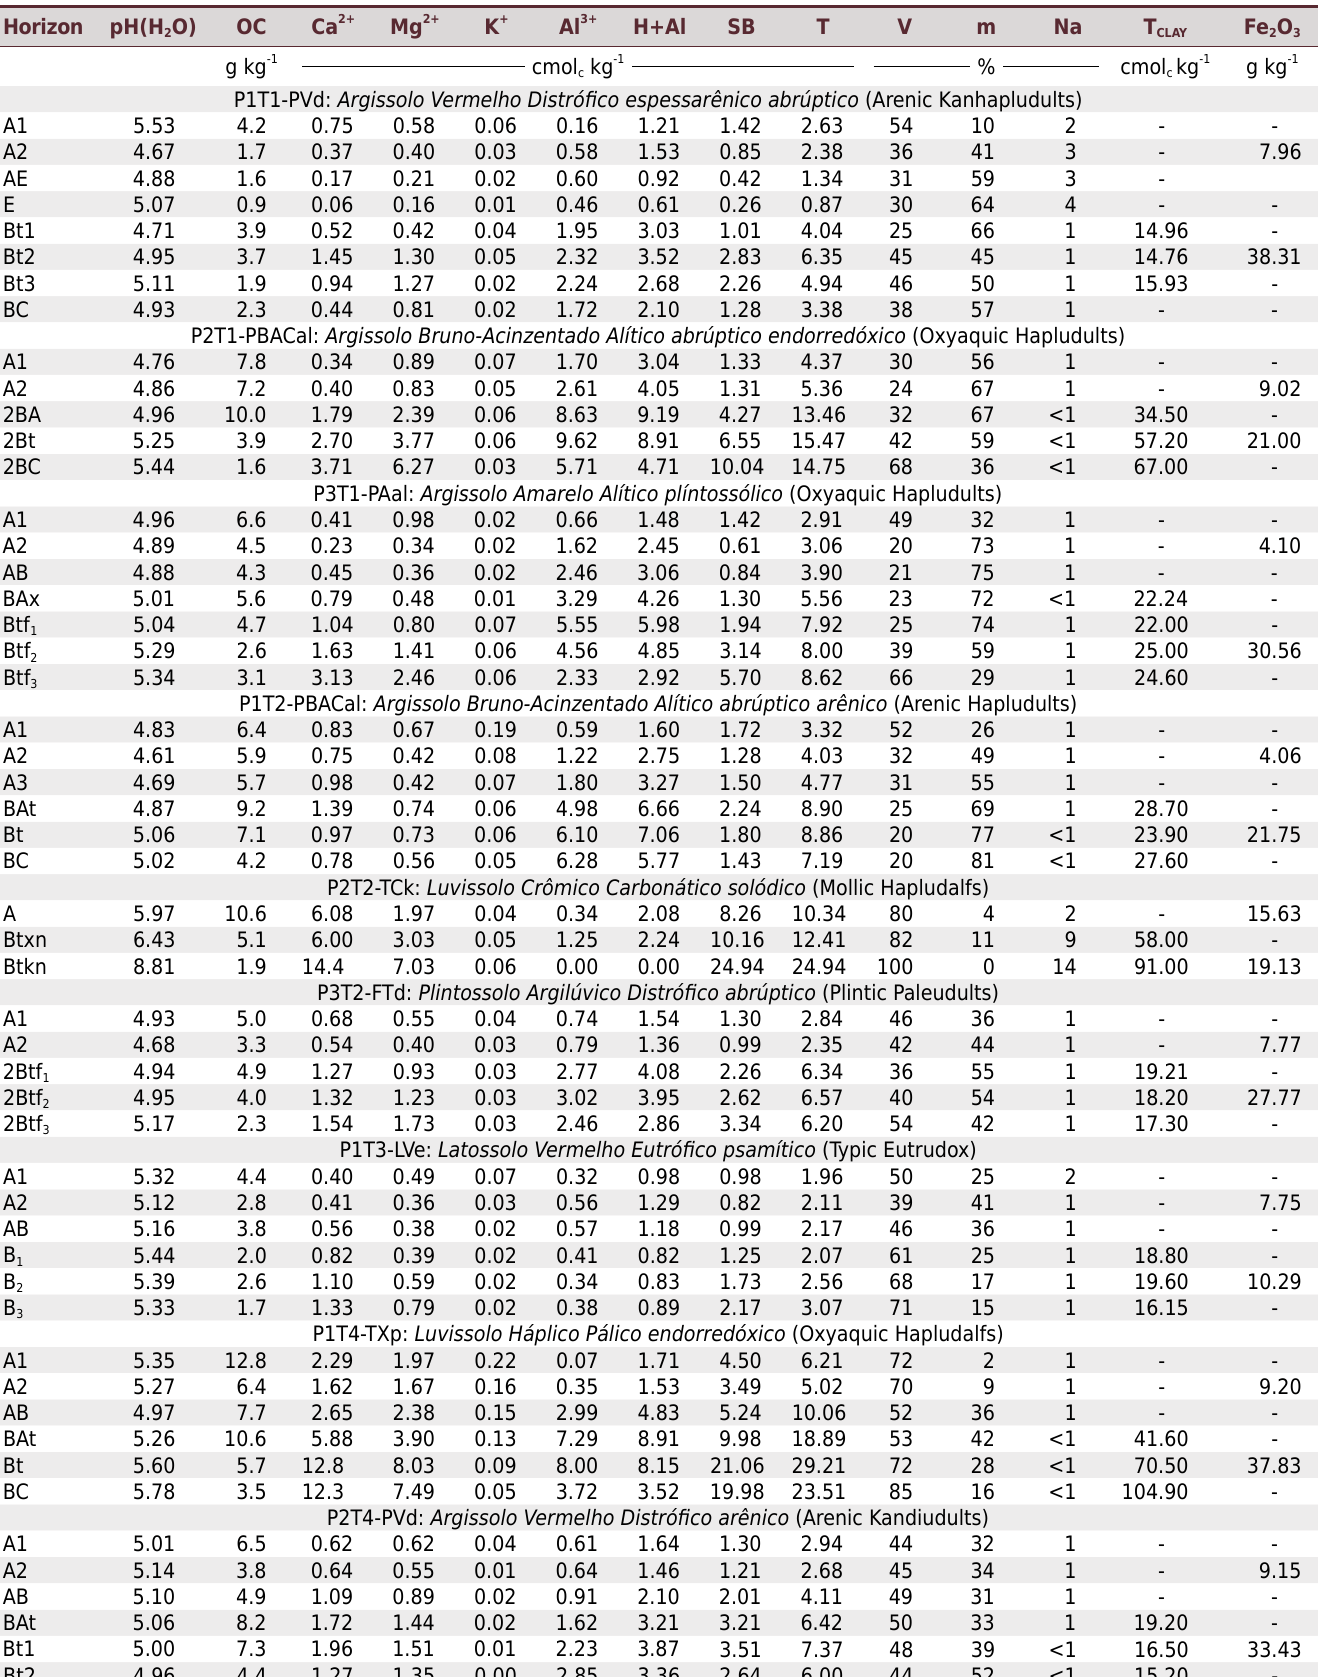
Table 3. Soil chemical properties in the A and B horizons of the studied profiles Horizon pH(H 2